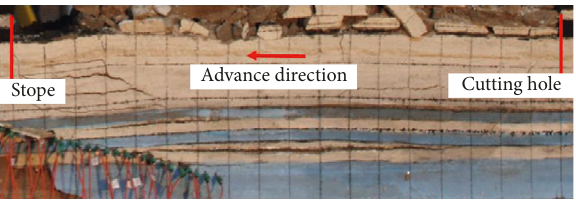
Figure 2: Fracture distribution of the